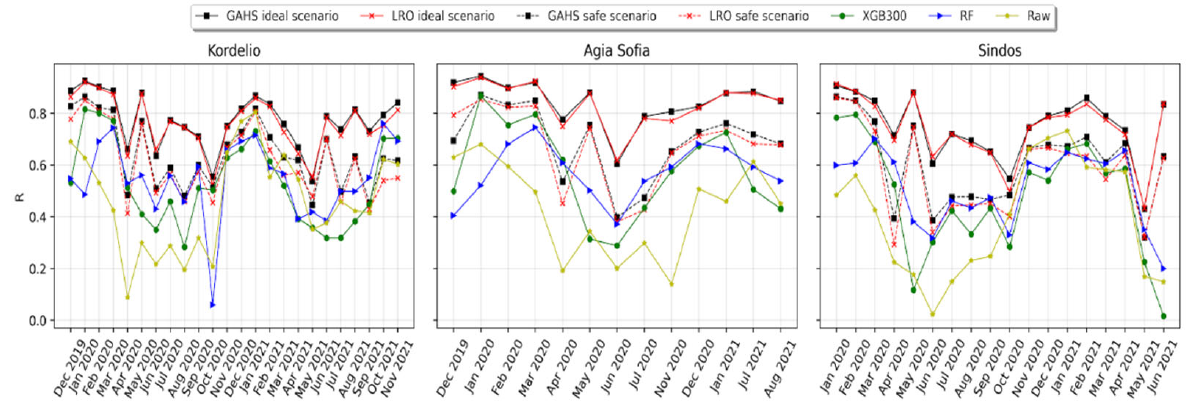
Figure 11. Comparison between the GAHS and the SOL frameworks and the best performing batch models in terms of Pearson correlation for PM 10 . The correlation coefficient between raw and reference measurements is also depicted.